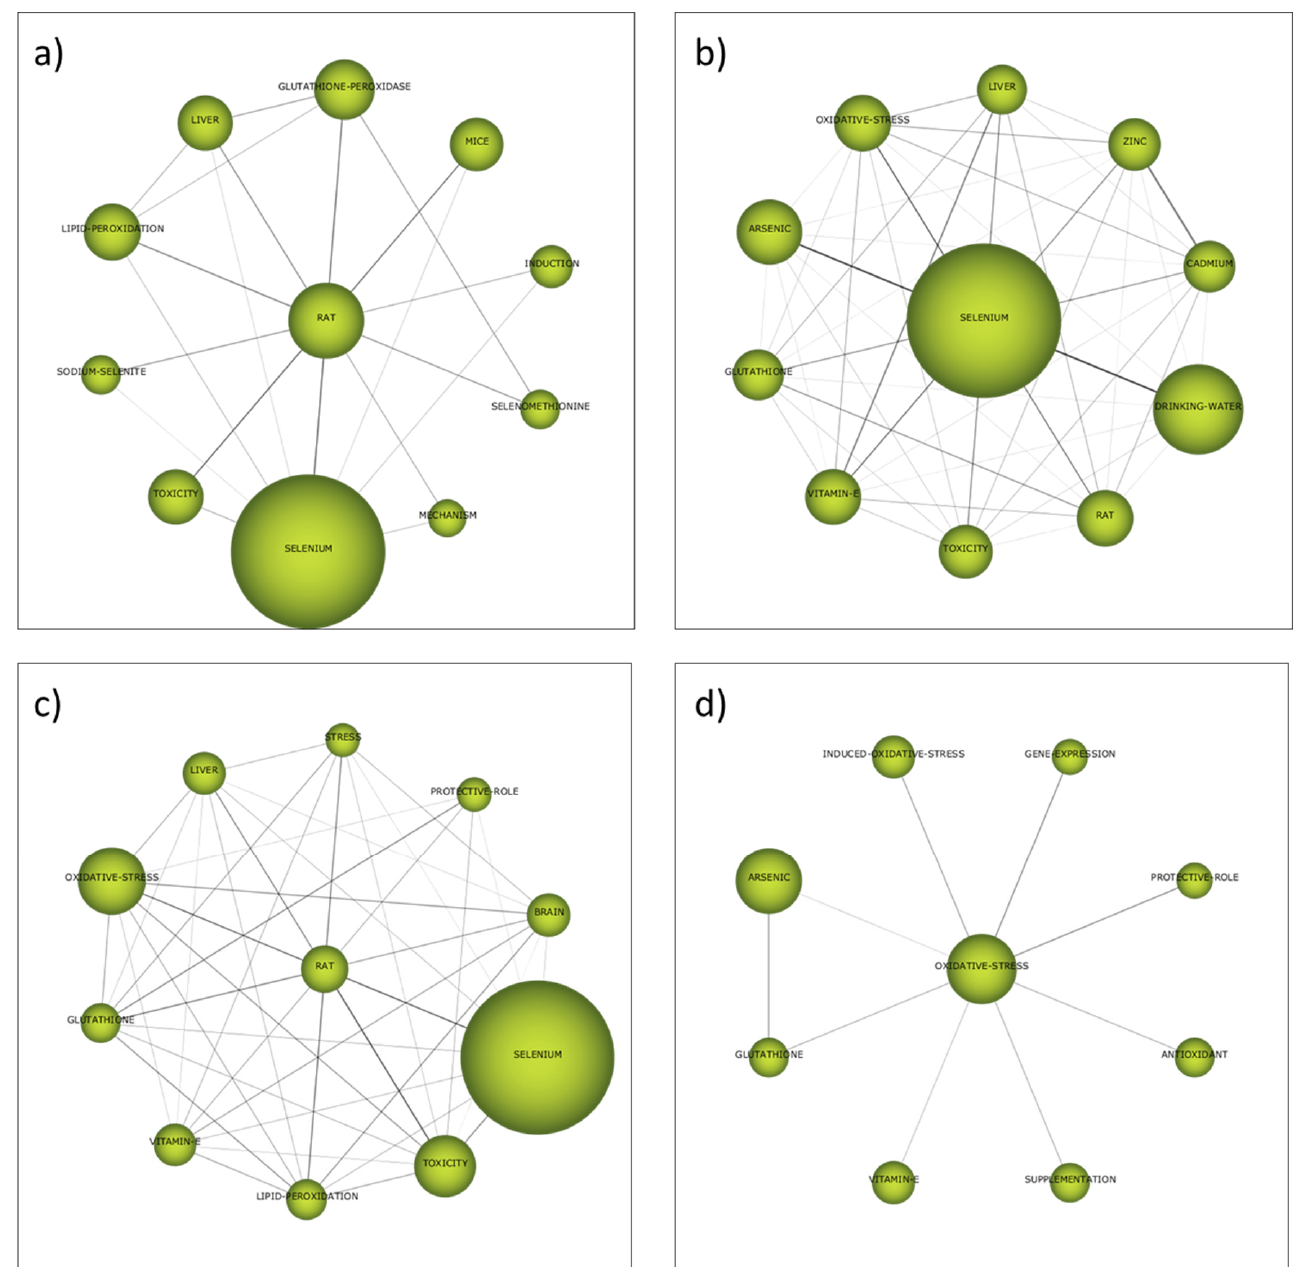
Figure 5. Thematic evolution structure of selenium and drinking water research (1990–2021).